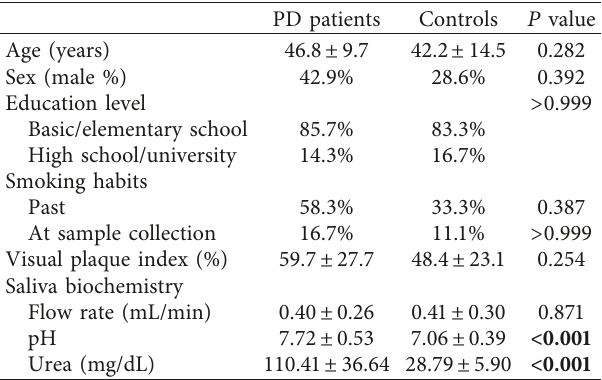
Table 2: Demographic information and parameters regarding oral hygiene of peritoneal dialysis (PD) patients and healthy controls.